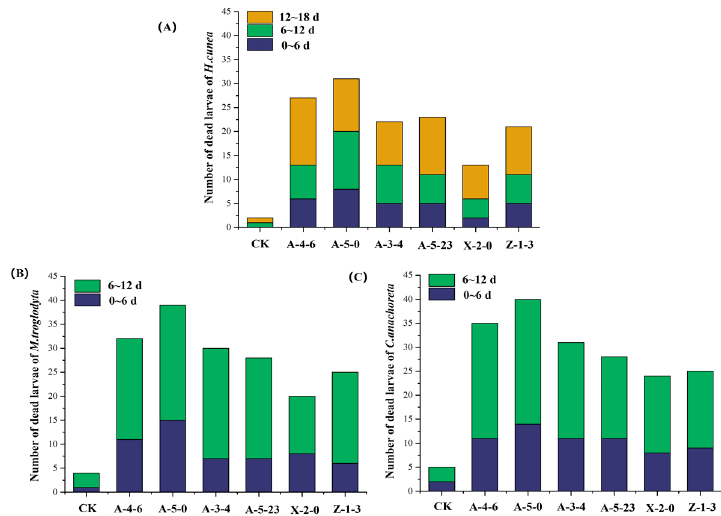
Figure 6. Number of target insect deaths. Mortality of H. cunea larvae ( A ), M. troglodyta larvae ( B ), and C. anachoreta larvae ( C ) that fed on transgenic poplar for different durations.